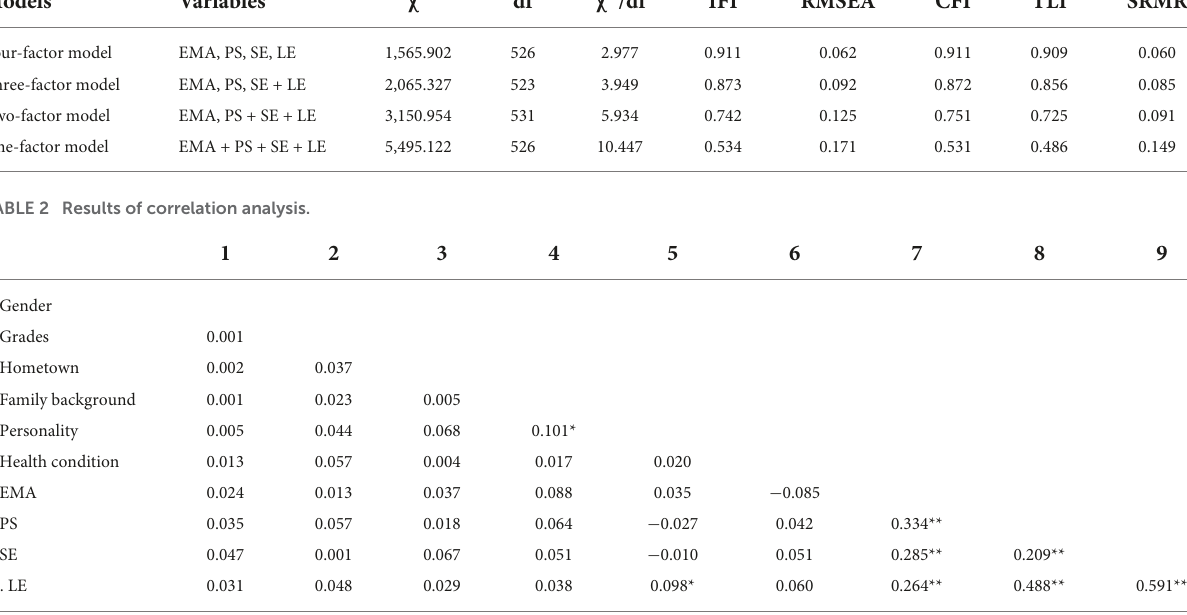
TABLE 1 Results of confirmatory factor analyses.